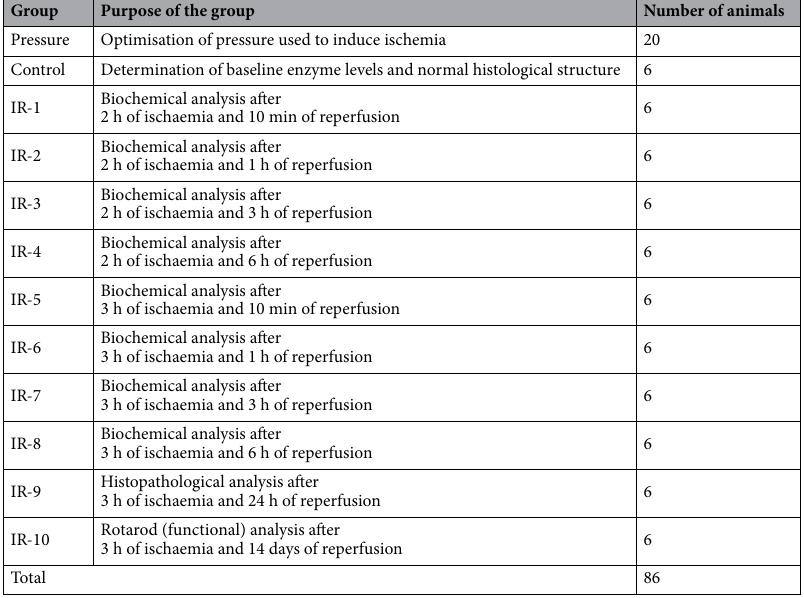
Table 2. Experimental groups. Description of experimental groups and animals used in each